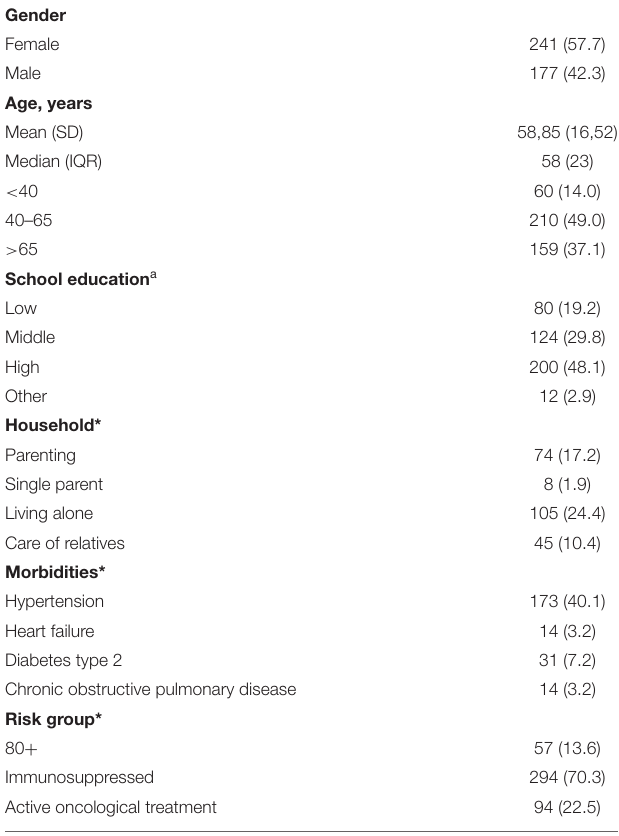
TABLE 1 | Participants characteristics ( N =